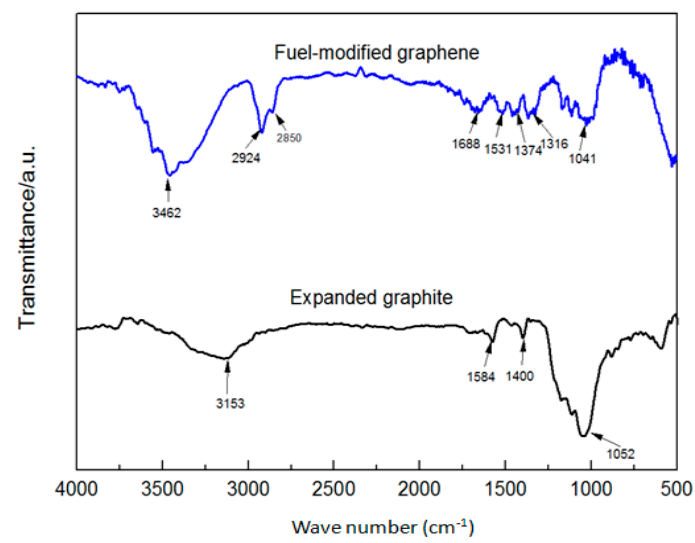
Figure 6. FTIR spectra of expended graphite and fuel-modified graphene.